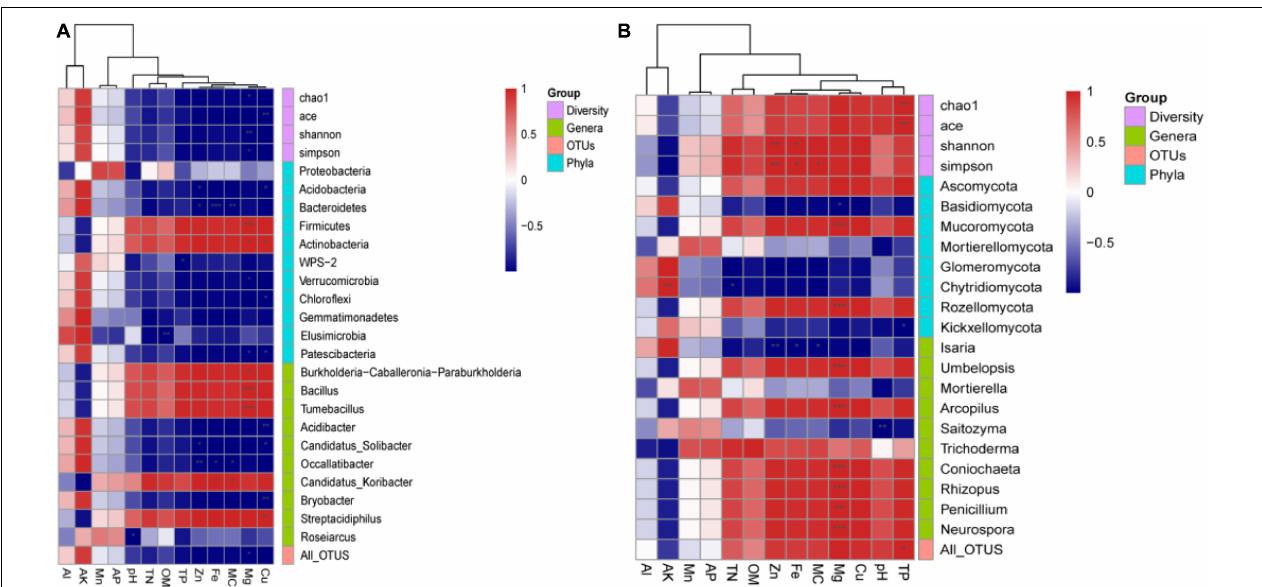
FIGURE 4 | The correlation between physicochemical parameters and alpha-diversity indices, all phyla, top 10 genera, and all operational taxonomic units (OTUs) of (A) bacterial and (B) fungal communities. Red represents a positive correlation, and blue represents a negative correlation (* p < 0.05, ** p < 0.01, and *** p <